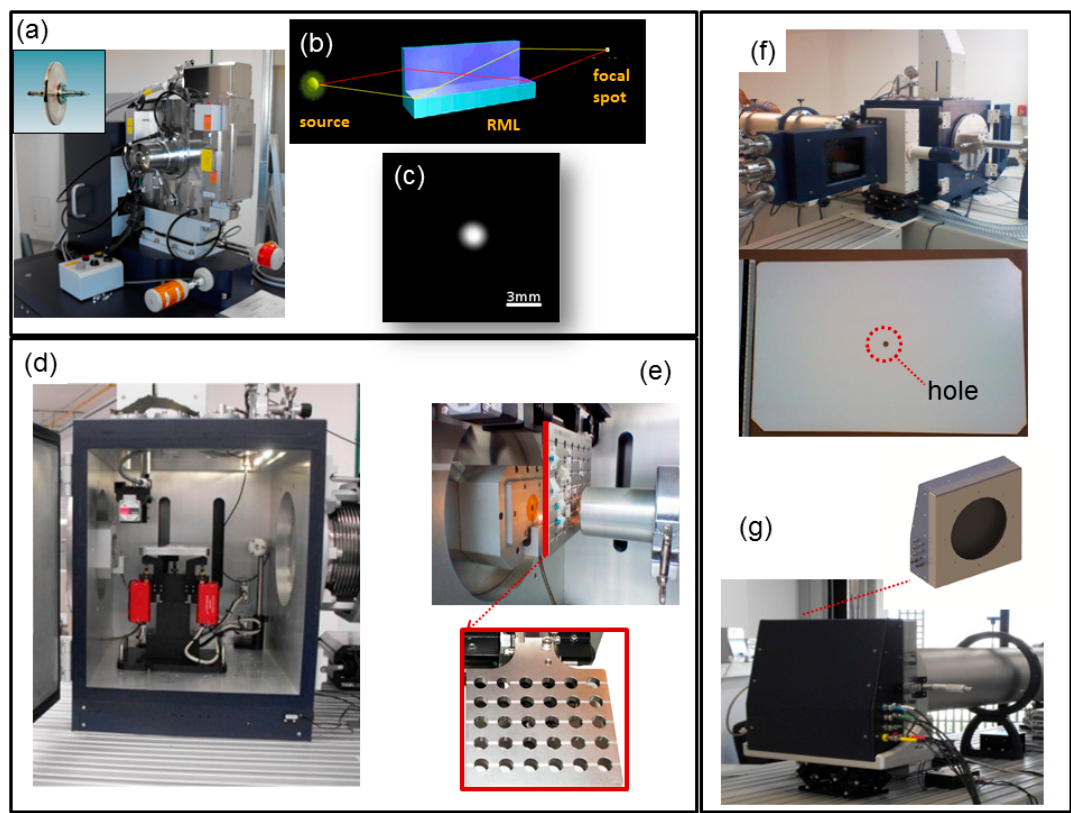
Figure 4. Different images of the XMI-L@b. ( a ) table-top rotating anode; ( b ) reflective multilayer (RML) confocal optics; ( c ) round shaped sub-millimetric focal beam spot; ( d ) sample chamber and GISAXS/GIWAXS goniometer; ( e ) sample holder for SAXS/WAXS data; ( f ) image plate (IP) detector, 250 × 160 mm in size, with 50 or 100 µm effective pixel size and off-line RAXIA reader, for WAXS data; ( g ) multi wire gas-filled detector with a 1024 × 1024 array, 195 µm pixel size for SAXS data. Partially reprinted with permission of the International Union of Crystallography from reference